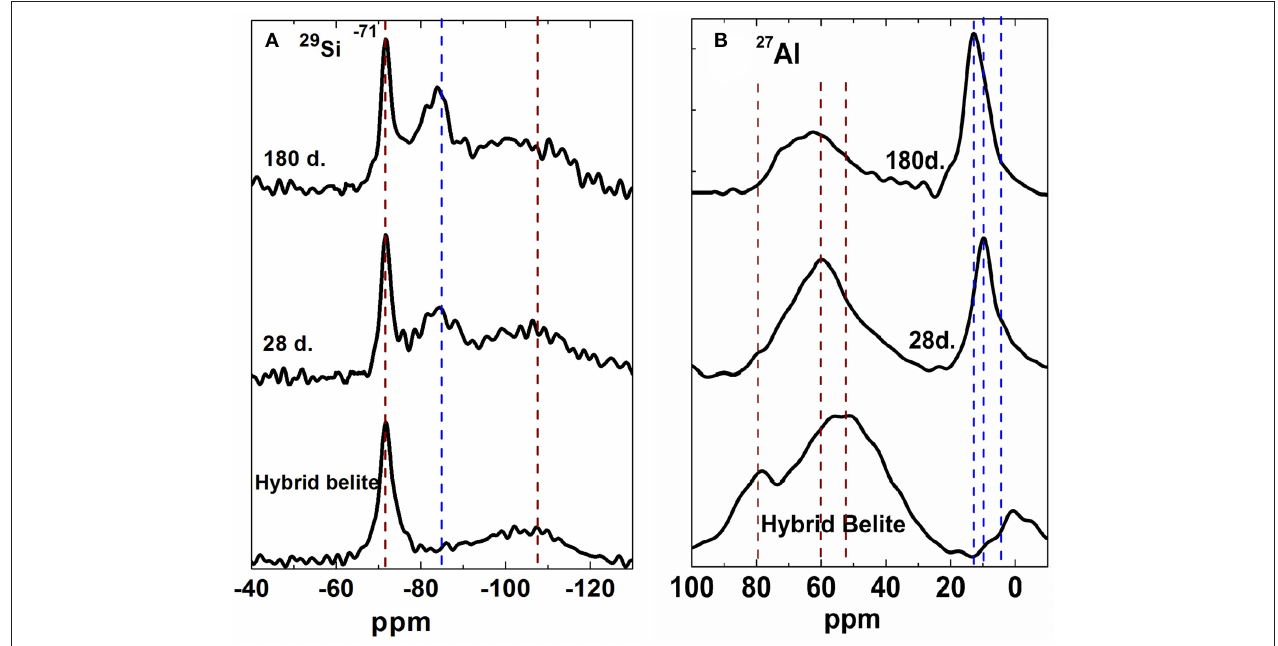
FIGURE 3 | (A) 29 Si MAS NMR and (B) 27 Al MAS NMR spectra for anhydrous hybrid alkaline-belite cement and 28 d and 180 d hydrated